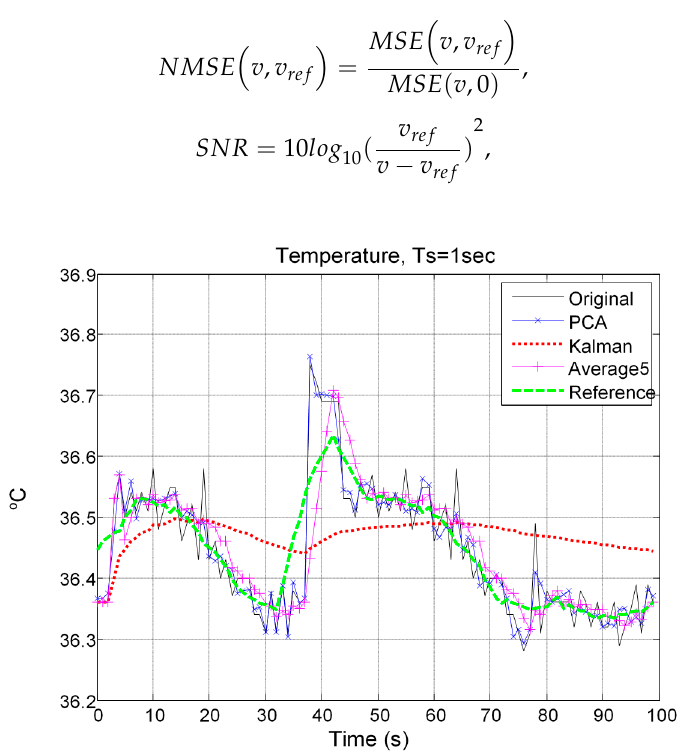
Figure 8. Temperature measurement with sampling period 1 s.